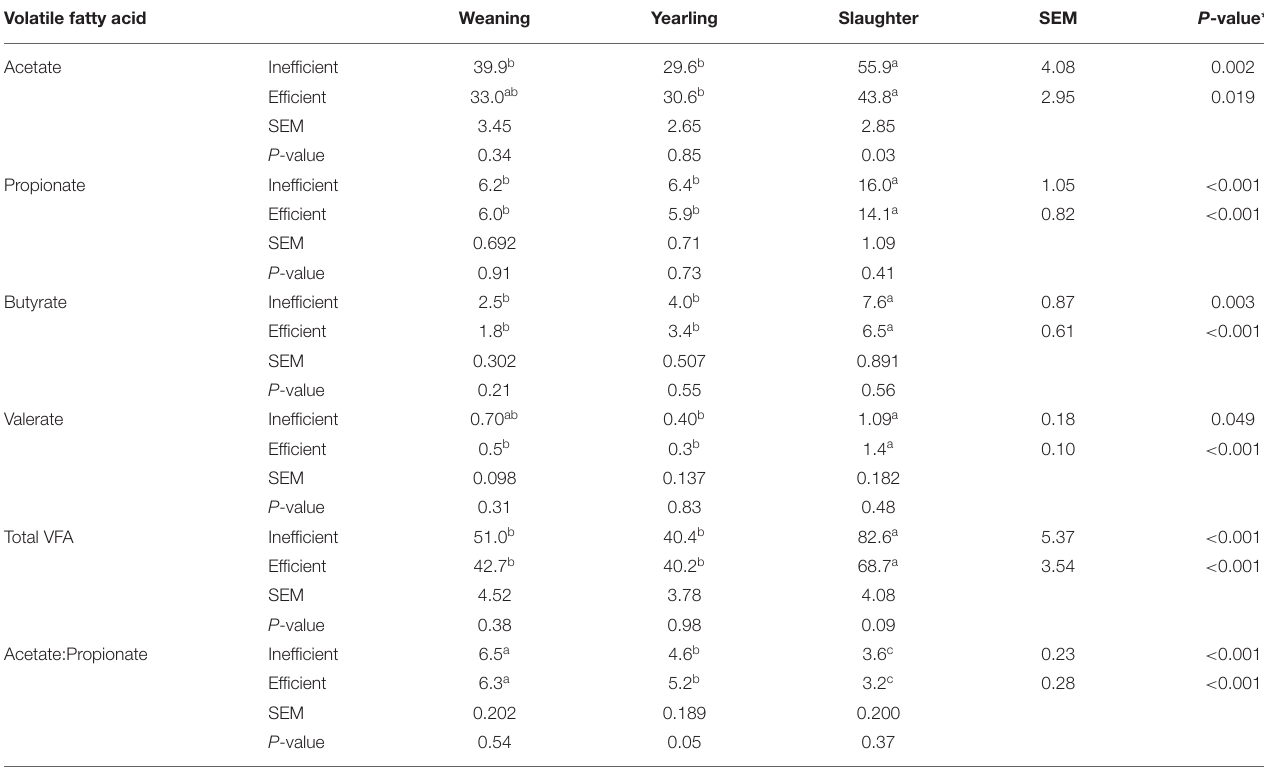
TABLE 3 | Volatile fatty acid (VFA) concentration (m M ) in the feces of efficient and inefficient steers at different stages of production: weaning, yearling, and kill floor (slaughter).